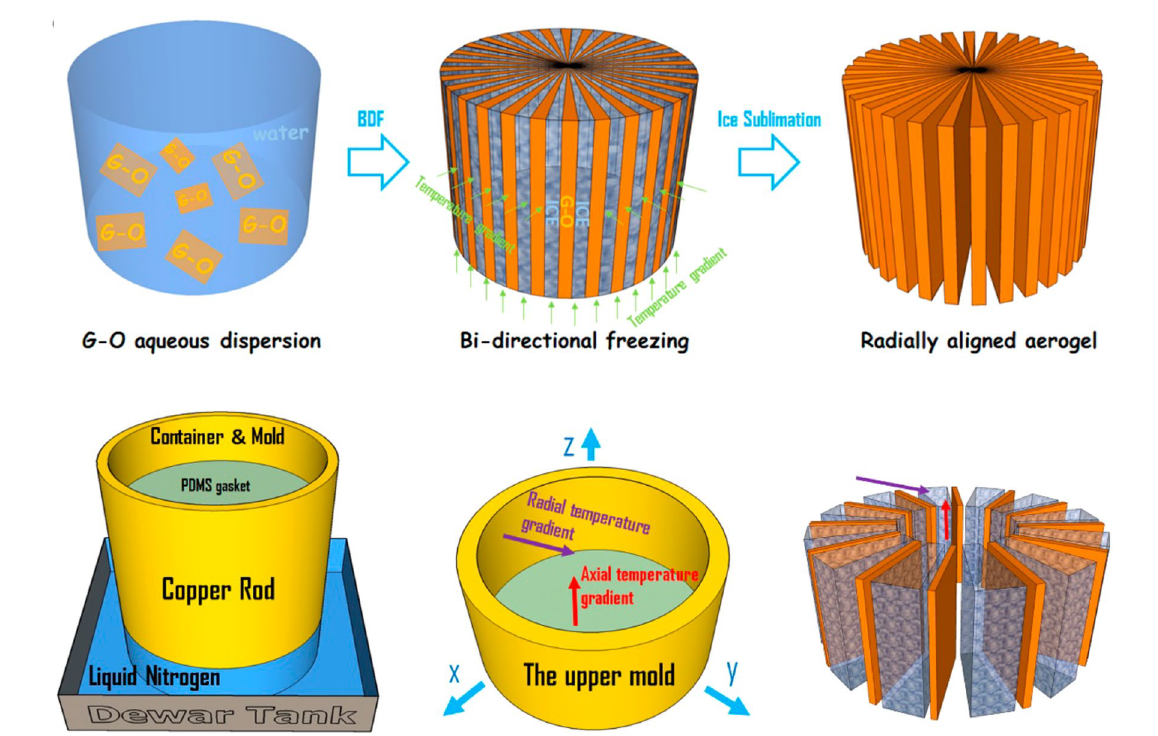
Fig. 12 Scheme of the fabrication process of radiating GA